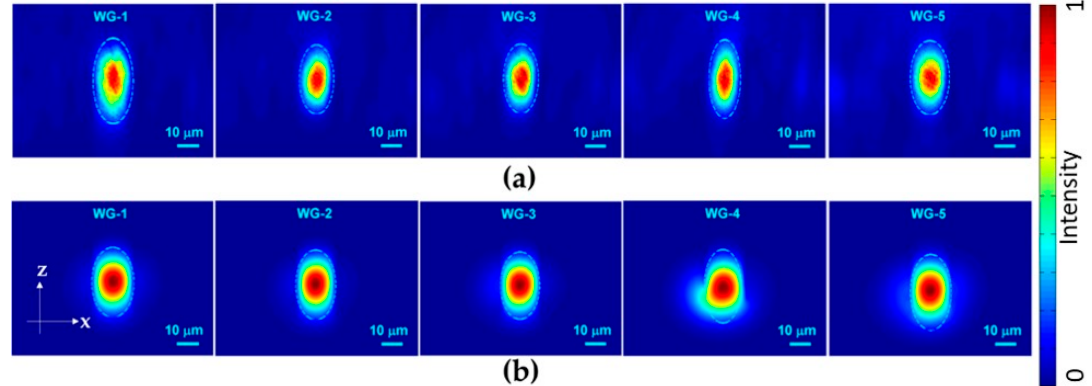
Figure 3 . Power density distribution (PDD) of both experimental-guided mode profiles (a) and Figure 3. Power density distribution (PDD) of both experimental-guided mode profiles ( a ) and simulated fundamental mode profiles for (b) of all the five waveguides. simulated fundamental mode profiles for ( b ) of all the five waveguides.